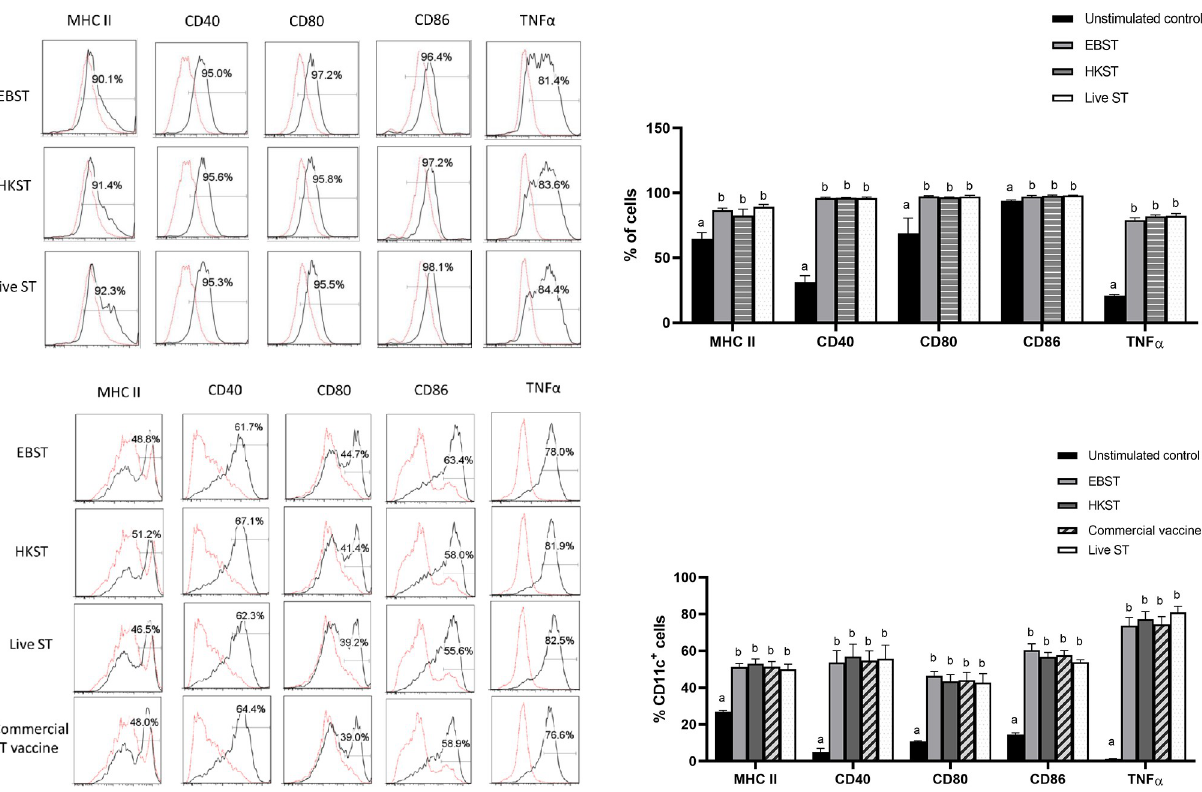
Fig 6. EBST induces efficient DC maturation and triggers proinflammatory cytokine production in DC2.4 cells and BMDC. DC2.4 cells were coincubated with EBST, HKST and live S . Typhimurium (MOI 1:10 for 24 h for surface markers and 4h for proinflammatory cytokine) as indicated to the left side of each row of histograms (Fig 6A). Each column of histogram represents expression level of surface markers MHC-II, CD40, CD80, CD86 and proinflammatory cytokine TNF α . Percentages in the gated region indicate the proportion of DC expressing high levels of various surface markers and TNF α . Expression levels of unstimulated DC (dotted red line) is compared to the antigen stimulated (thin black line) DC2.4 cells. Data are representative of three independent experiments. Bar graph summarizes the results from three independent experiments (Fig 6B). BMDCs were coincubated with EBST, HKST, live S . Typhimurium and a commercially available live attenuated ST vaccine (MOI 1:10 for 24 h for surface markers and 4h for proinflammatory cytokine) as indicated to the left side of each row of histograms (Fig 6C). Each column of histogram represents expression level of surface markers MHC-II, CD40, CD80, CD86 and proinflammatory cytokine TNF α . Percentages in the gated region indicate the proportion of CD11c + DC expressing high levels of various surface markers and TNF α . Expression levels of unstimulated DC (dotted red line) is compared to the antigen stimulated (thin black line) DC. Data are representative of three independent experiments. Bar graph summarizes the results from three independent experiments (Fig 6D). Bars with differing letters indicate significant (p < 0.05) differences among groups for each individual activation